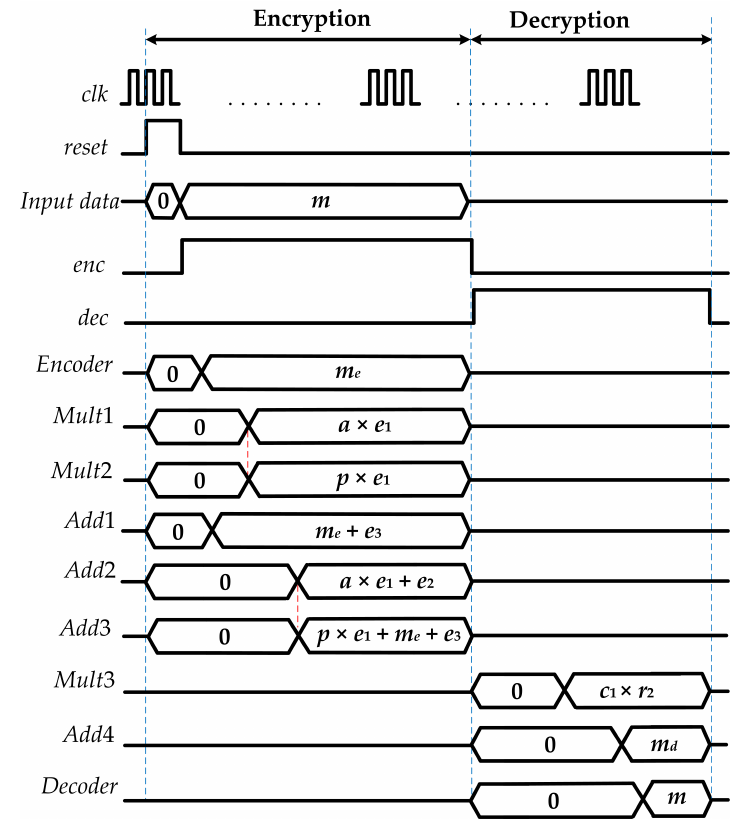
Figure 4. Timing diagram of proposed ring-LWE